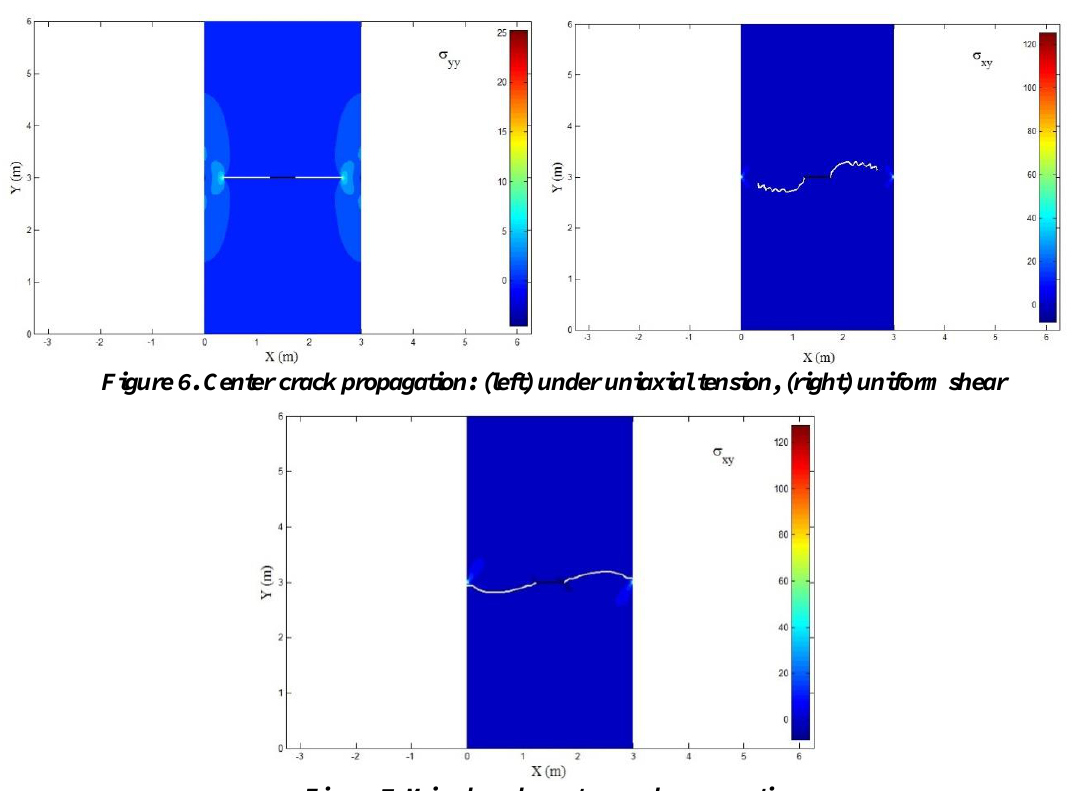
Figure 7. Mixed mode center crack